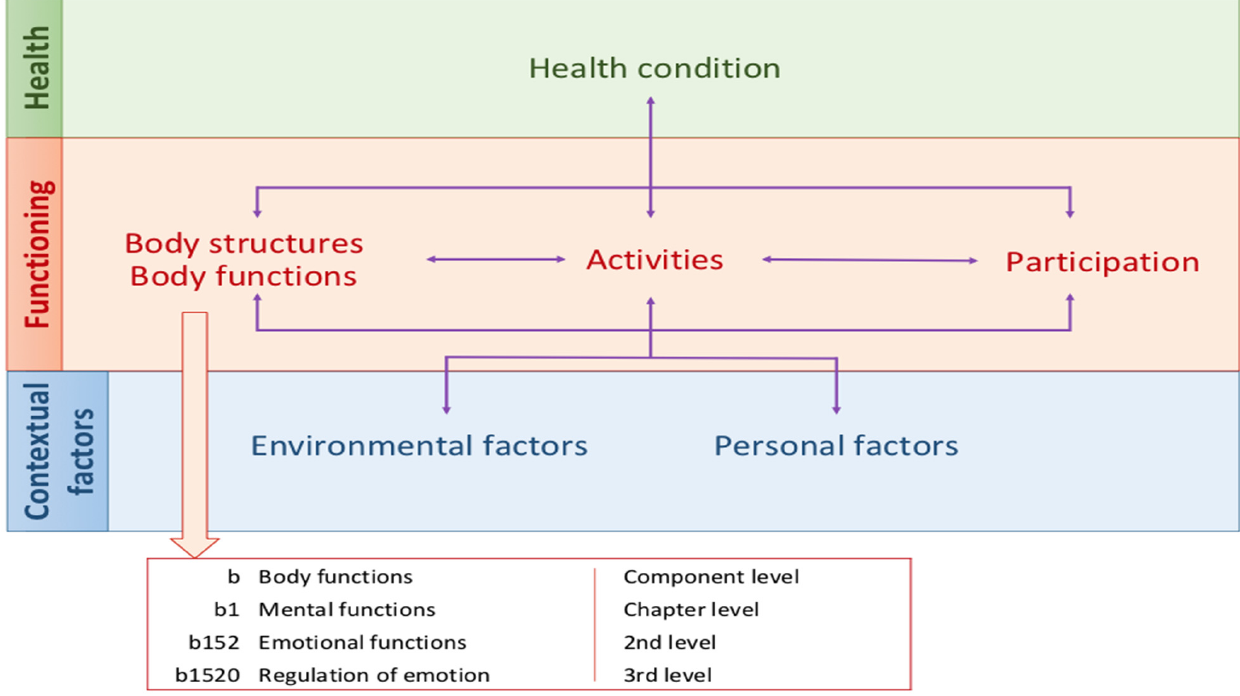
Figure 1. The ICF Figure 1. The ICF structure.